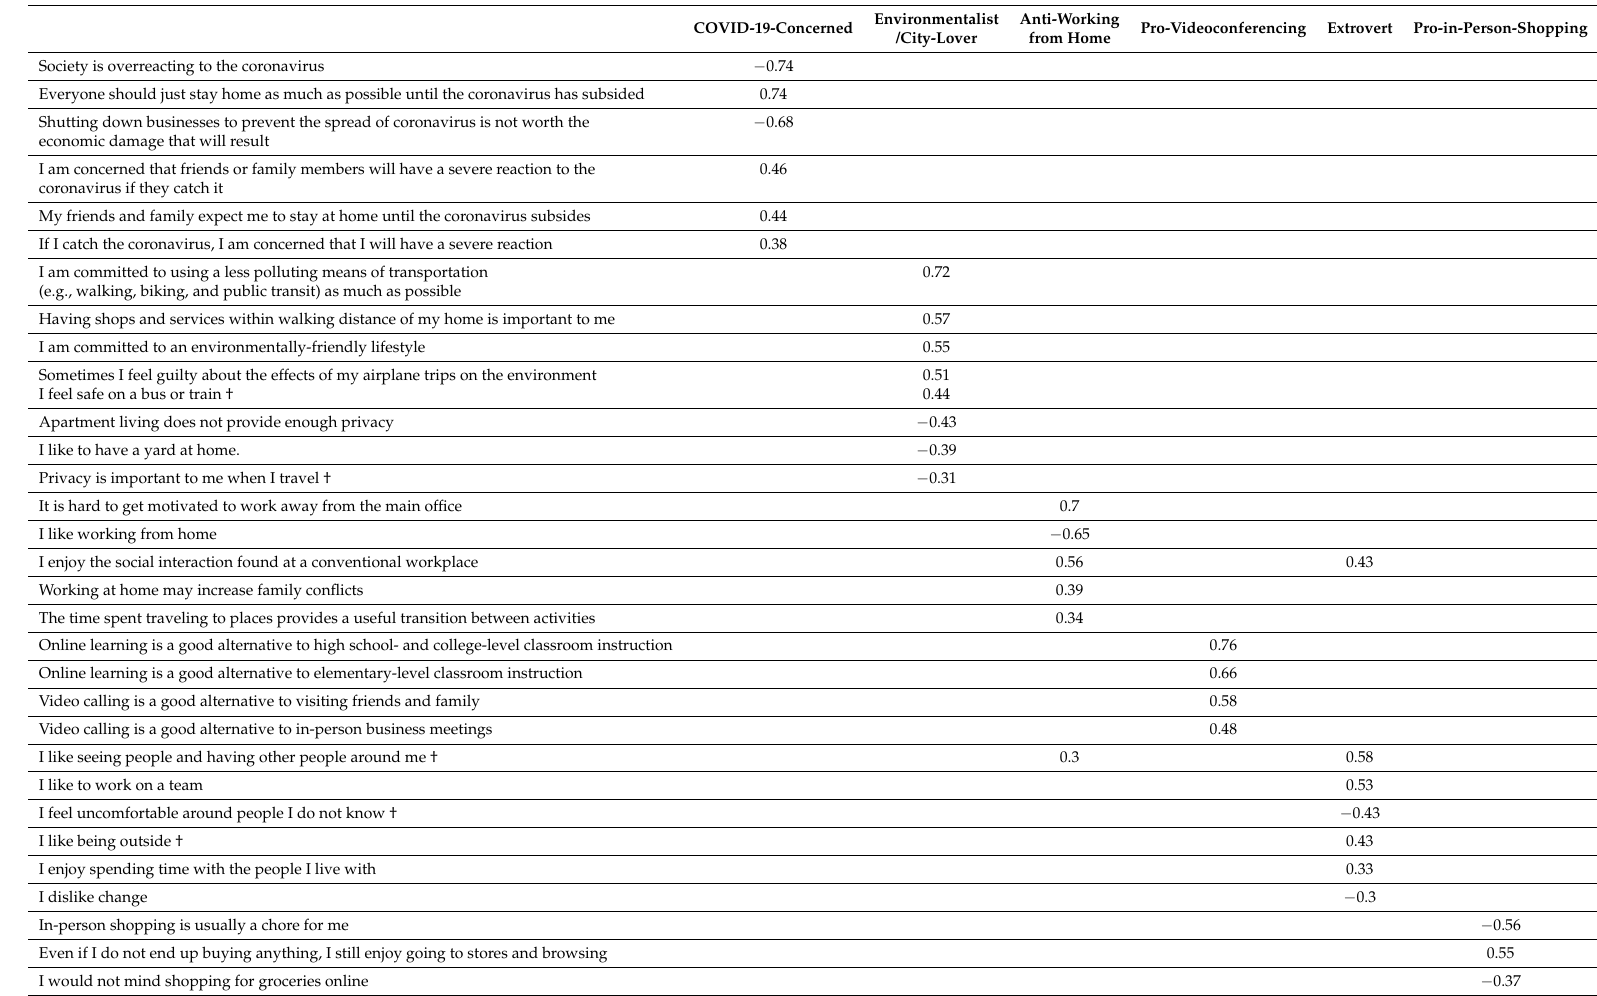
Table A1. Pattern matrix loadings for exploratory factor analysis of attitudinal statements (Varimax rotation). Only loadings greater in magnitude than 0.3 are shown. COVID-19-Concerned Environmentalist Anti-Working Pro-Videoconferencing Extrovert Pro-in-Person-Shopping /City-Lover from Home −